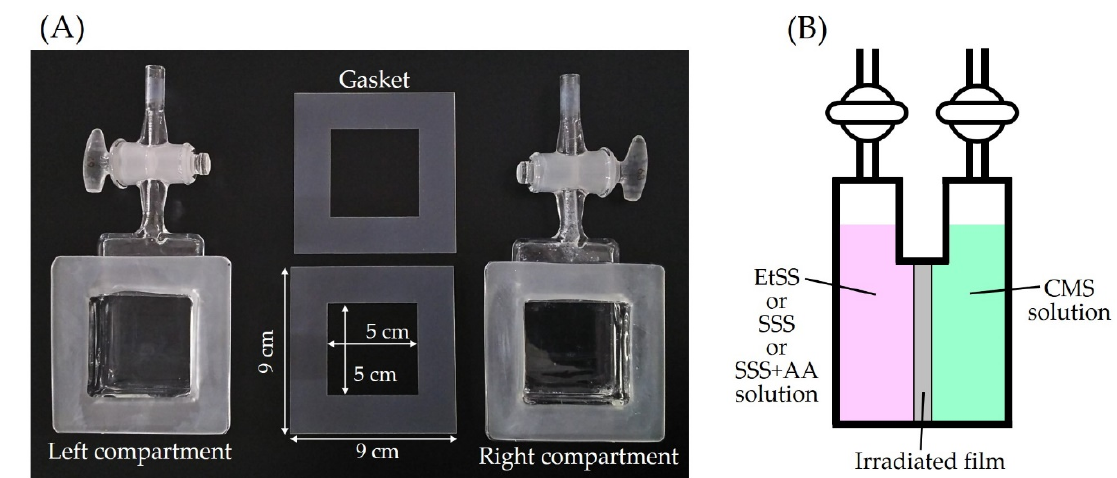
Figure 1. ( A ): Picture of the two-compartment glass cell for radiation-induced asymmetric graft polymerization (RIAGP). The irradiated film was located between two gaskets. ( B ): Schematic diagram of RIAGP. Two different monomer solutions were injected into the left and right compartments.